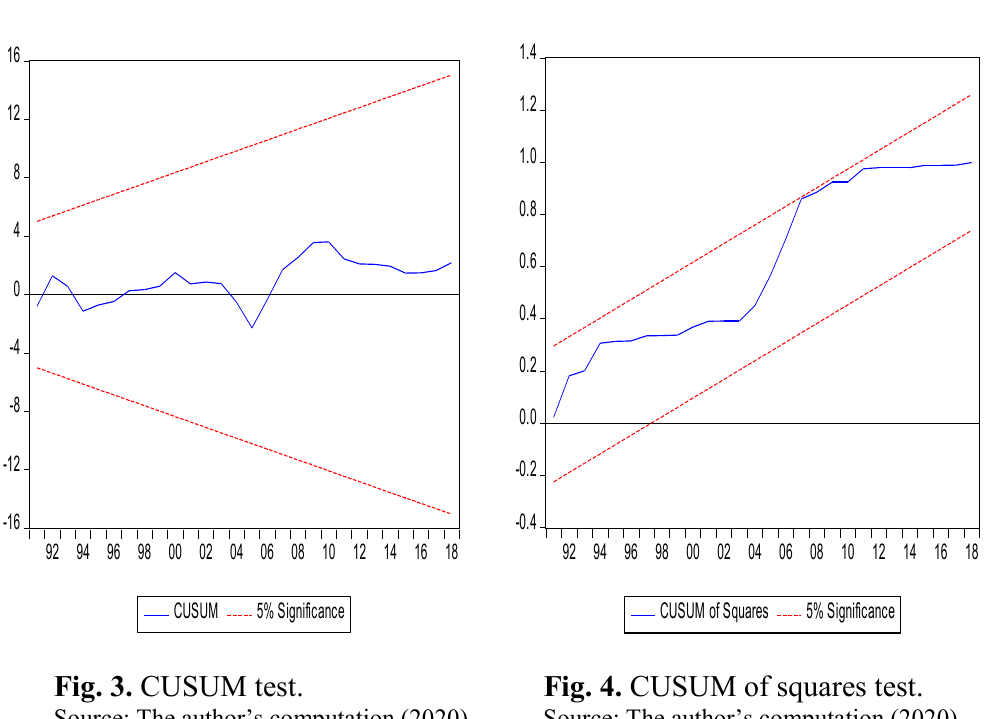
Fig. 3. CUSUM test. Fig. 4. CUSUM of squares test.